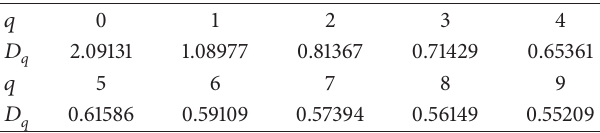
Figure 15: The schematic figure of equipment under test and measurement layout. Table 9: The generalized dimension value of bearing cages fault signal.